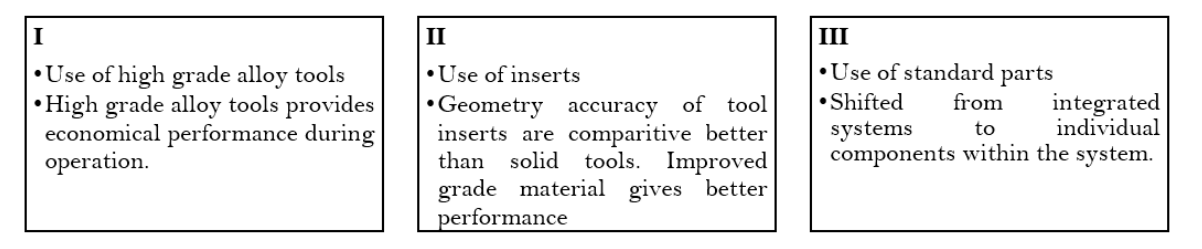
Figure 9. Suggestion to mitigate tooling failure.